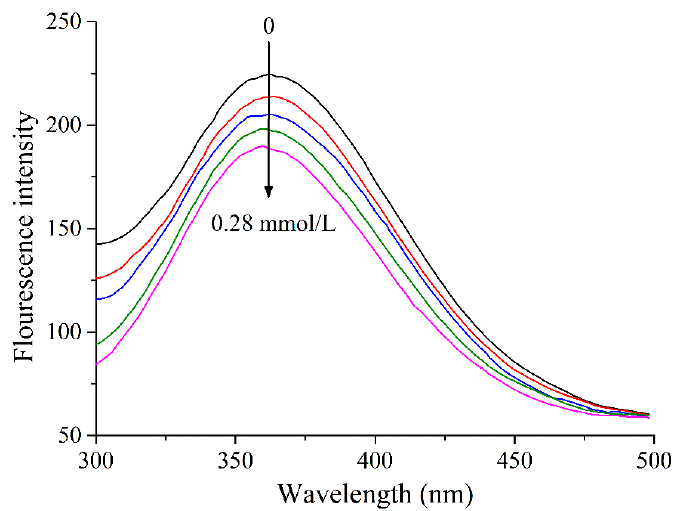
Figure 2. Fluorescence quenching spectra of Semen Cassiae proteins at 25.0 °C, concentration of soluble proteins 0.2 g/L, and physcion concentrations of 0, 0.07, 0.14, 0.21 and 0.28 mmol/L.